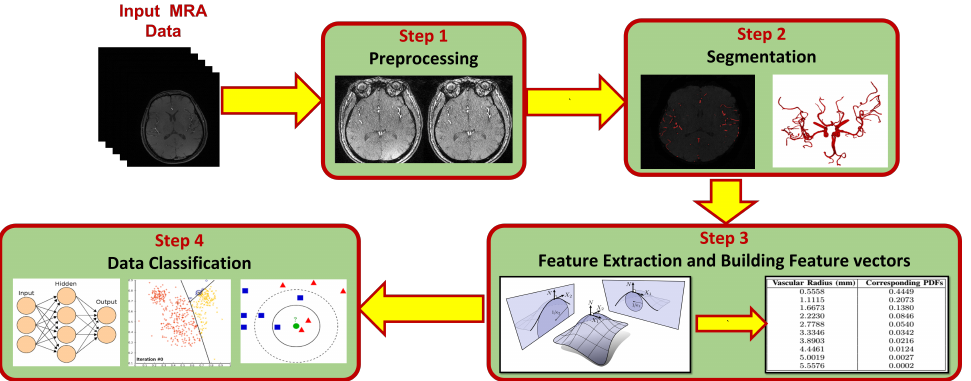
Figure 1. A block diagram showing modules of the proposed framework for classifying hypertension